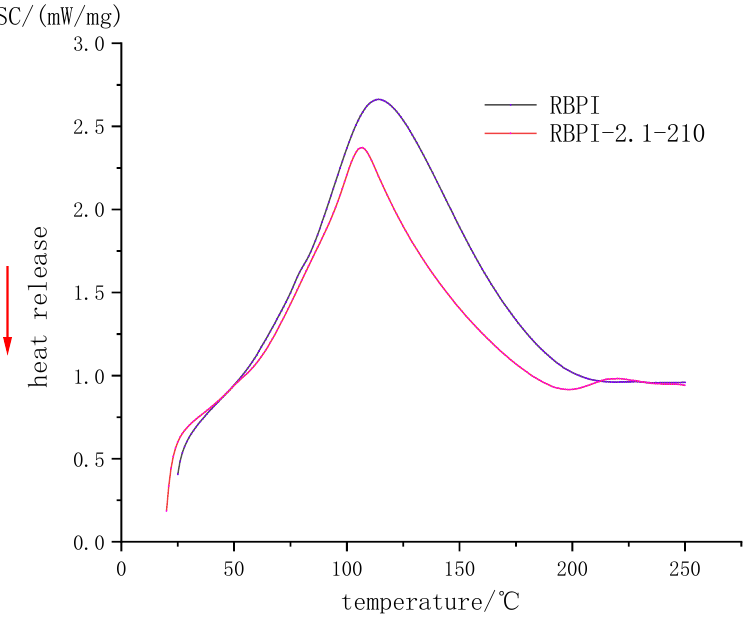
Figure 3. DSC Profile of rice bran protein isolate. Table 1. Thermal transition characteristics of rice bran protein isolate.